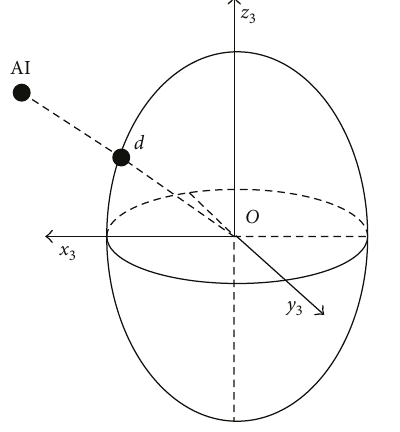
Figure 10: Point AI projects on the elliptical surface.